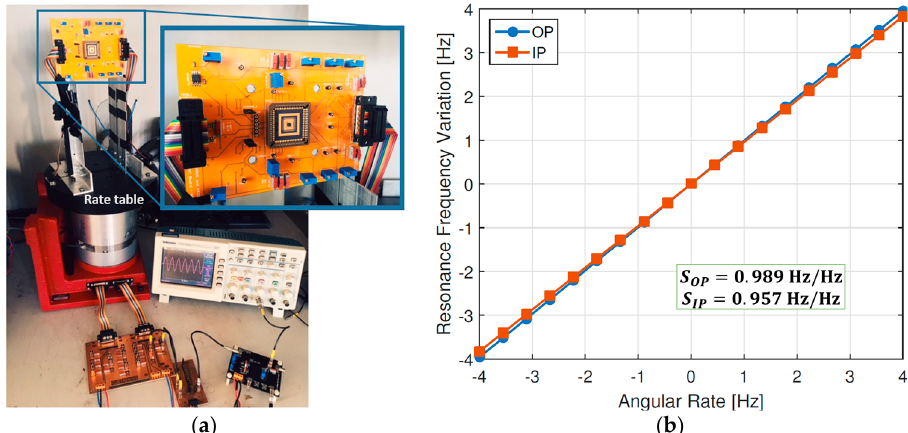
Figure 3. ( a ) Experimental set-up: the MEMS and the IC are stacked and wire-bonded in a socket (close-up view), and then placed on the rate table; ( b ) Measured resonance frequency variation as a function of the rate, for both OP and IP modes. Scale factor errors are greatly reduced when measuring the sum of both axes variations